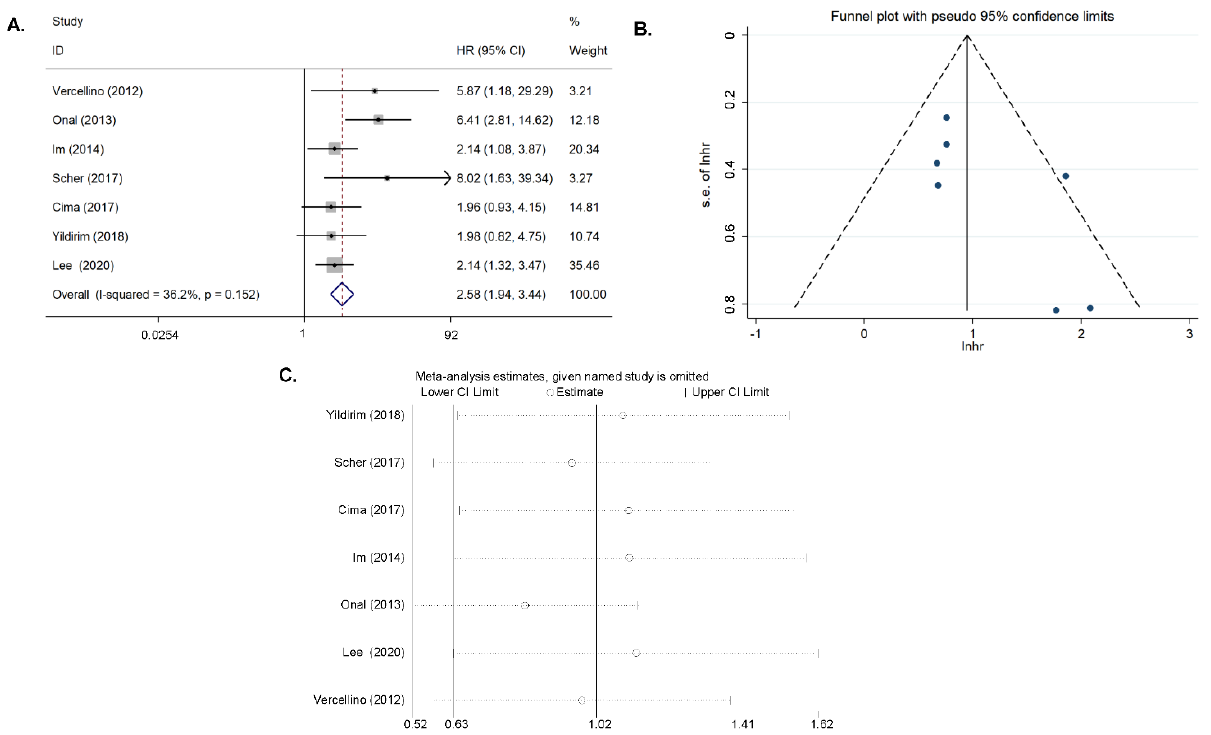
Figure 3. Results for the primary SUV max for OS. ( A ) Forest plots of the HRs. ( B ) Begg’s funnel plot. ( C ) Sensitivity analysis of the influence of each individual study on the pooled HR.